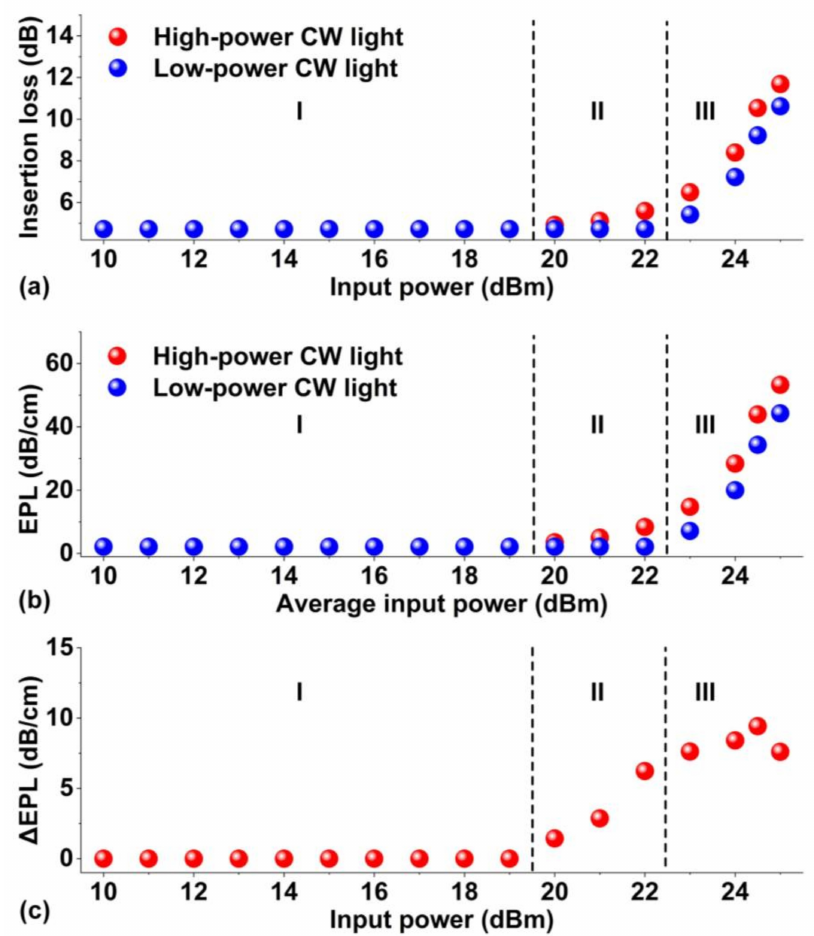
Figure 3. Experimental results for characterizing PTT of the hybrid waveguide coated with 1 layer of GO. ( a ) Insertion loss of the hybrid waveguide versus the input power of the high-power light source. The red dots show the loss of the high-power CW light source, and the blue dots show the loss measured with a low-power CW light source after exposure at the power level indicated on the X-axis. ( b ) GO-induced excess propagation loss ( EPL ) versus input power of the high-power light source. The red and blue dots show the results corresponding to the red and blue dots in ( a ), respectively. ( c ) ∆ EPL extracted from ( b ) showing the difference between the red and blue dots. In ( a – c ), I–III show the three reduction stages during the PTT